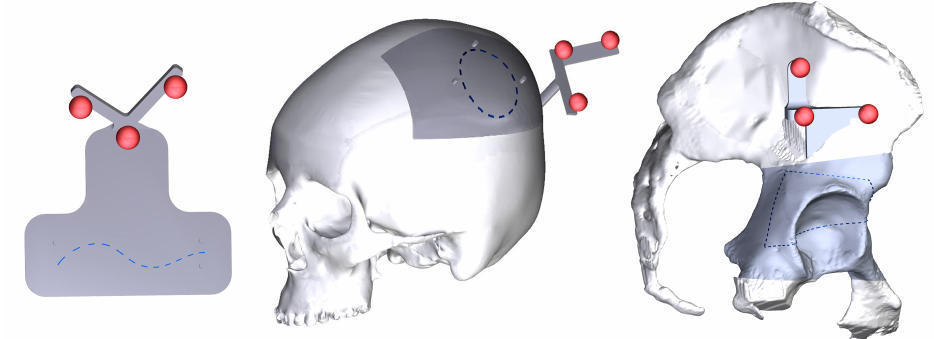
Figure 2. The three trajectories designed for the AR platform evaluation. From the left to the right: T1 over the top side of a rectangular plate, T2 on the surface of a patient-specific skull model, T3 on the surface of a patient-specific acetabular model.